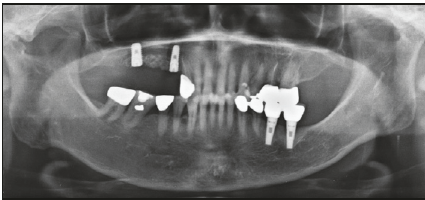
Figure 9: Postoperative radiographic view (panoramic X-ray image). Implant reinstallation on #14 and #16 regions four months after the implant